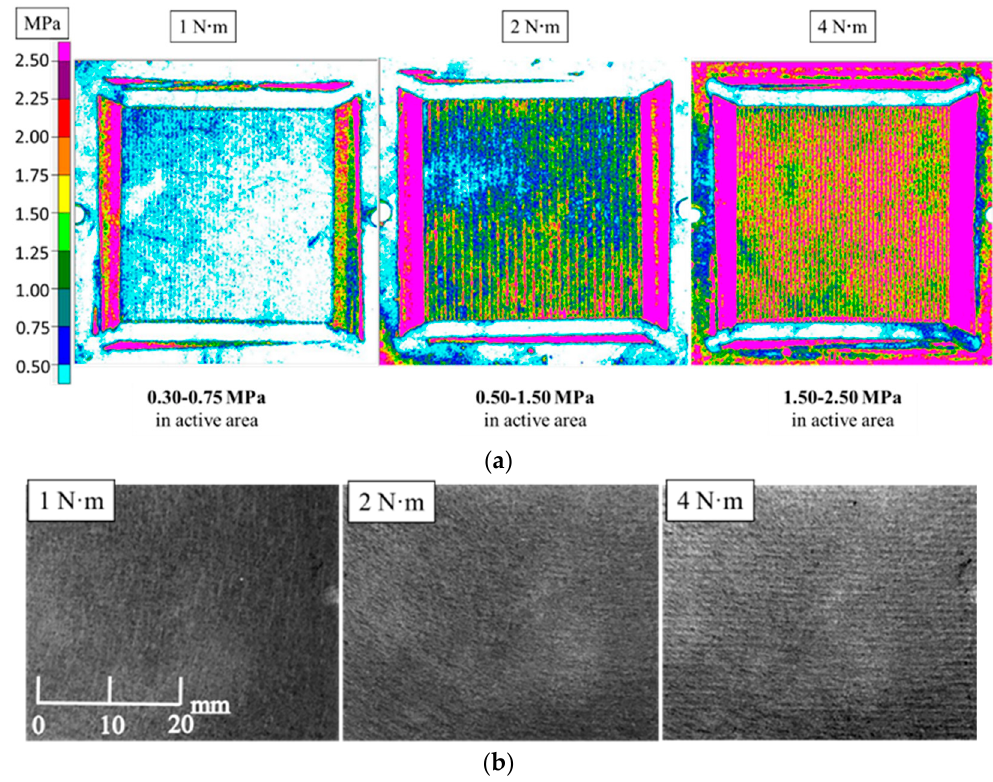
Figure 4. Assembly pressure distribution between catalytic layer (CL) and microporous layer (MPL) and morphology changes of GDL surface at different assembly pressures: ( a ) Assembly pressure distribution between CL and MPL under different bolt torques; ( b ) Surface morphology of GDL at different assembly pressures.